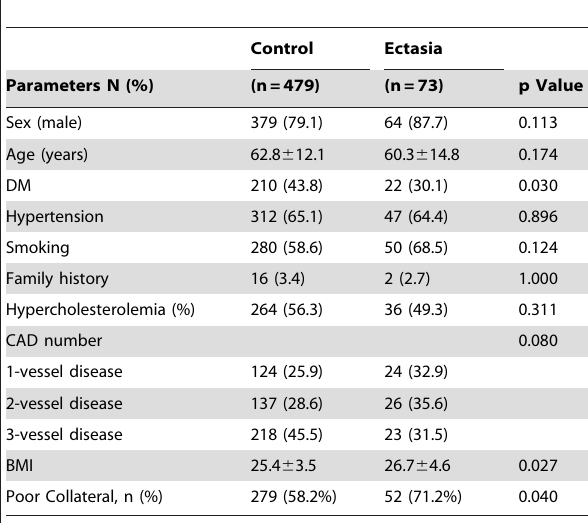
Table 1. Angiographic Characteristics of the Patients With Coronary Ectasia.